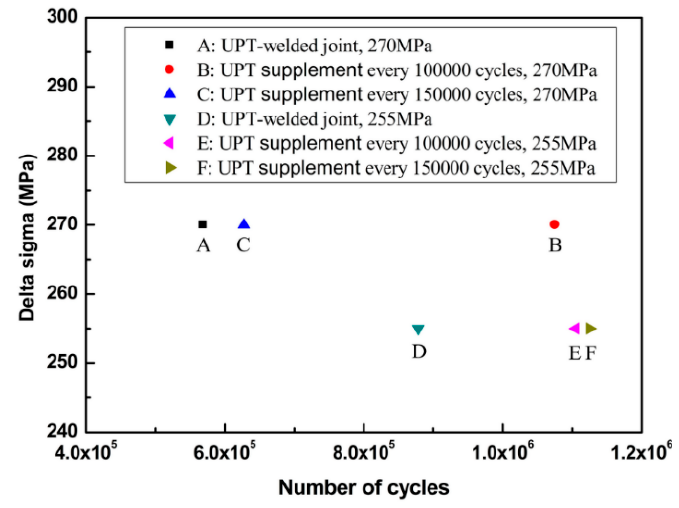
Figure 5. Fatigue data of UPT-welded joints and as-welded joints.